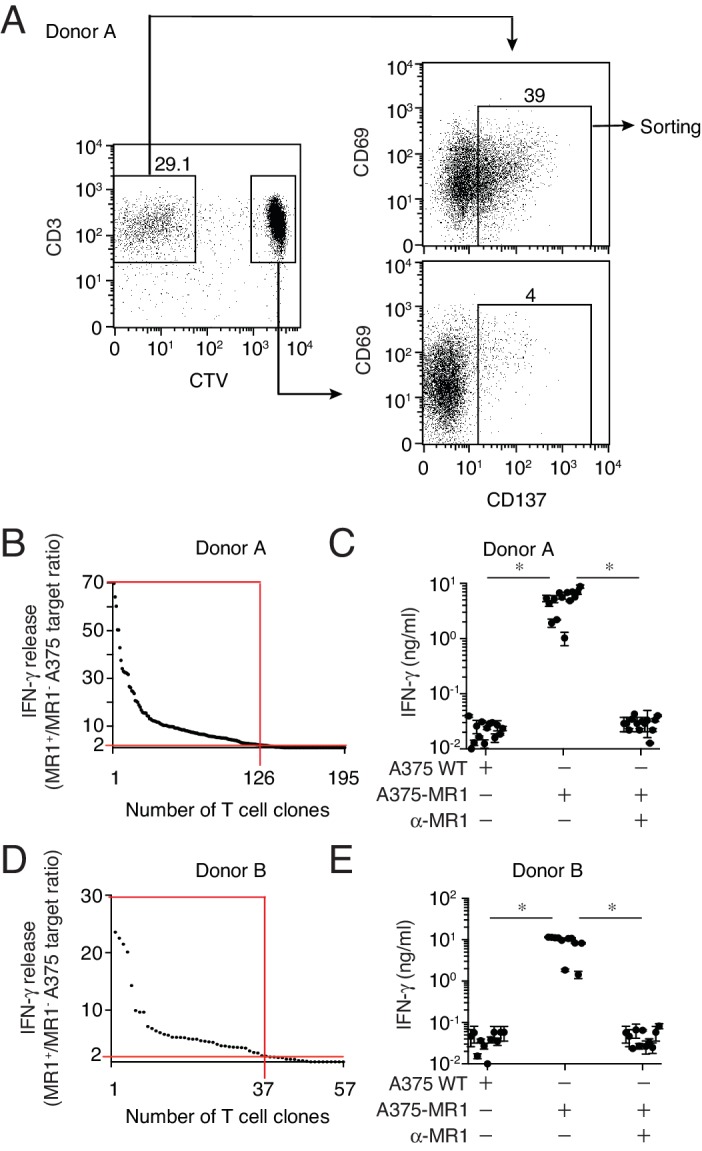
Isolation of non-MAIT MR1-restricted T cell clones after stimulation with A375-MR1 cells in the absence of microbial antigens.(A) FACS analysis of purified T cells previously expanded with irradiated A375-MR1 cells following overnight co-culture with A375-MR1 cells. Left dot plot shows CD3 and CellTrace violet (CTV) staining in live cells. Upper right and bottom right dot plots show CD69 and CD137 expression on CD3+CTV− and CD3+CTV+ gated cells, respectively. Arrows indicate gating hierarchy. Numbers indicate the percentages of cells within the gates. Cells from Donor A are illustrated as a representative donor. (B, D) Cumulative results of T cell clones screening from Donors A and B. T cell clones were generated from CD3+CTV-CD137high sorted T cells as depicted in A. Graphs show the individual clones (x axis) and their IFN-γ release (y axis), expressed as ratio between the amount of cytokine secreted in response to A375-MR1 cells vs. A375 WT cells. Each dot represents a single T cell clone, tested at the same time in the indicated experimental conditions. The horizontal red line marks the arbitrary IFN-γ ratio cut-off of two, above which MR1-dependent T cell clone reactivity was set. The intercept of the vertical red line indicates the number of MR1-restricted T cell clones in each donor. Red boxes highlight T cell clones whose reactivity was MR1-dependent. Results are representative of two independent experiments. (C, E) IFN-γ release by 14 representative clones from Donor A and 11 clones from Donor B after stimulation with A375 WT, A375-MR1 and A375-MR1 in the presence of blocking anti-MR1 mAbs (α-MR1). Dots represent the IFN-γ release (mean ± SD of duplicate cultures) by each clone. Results are representative of three independent experiments. *p<0.05 (Unpaired Student’s t-test).